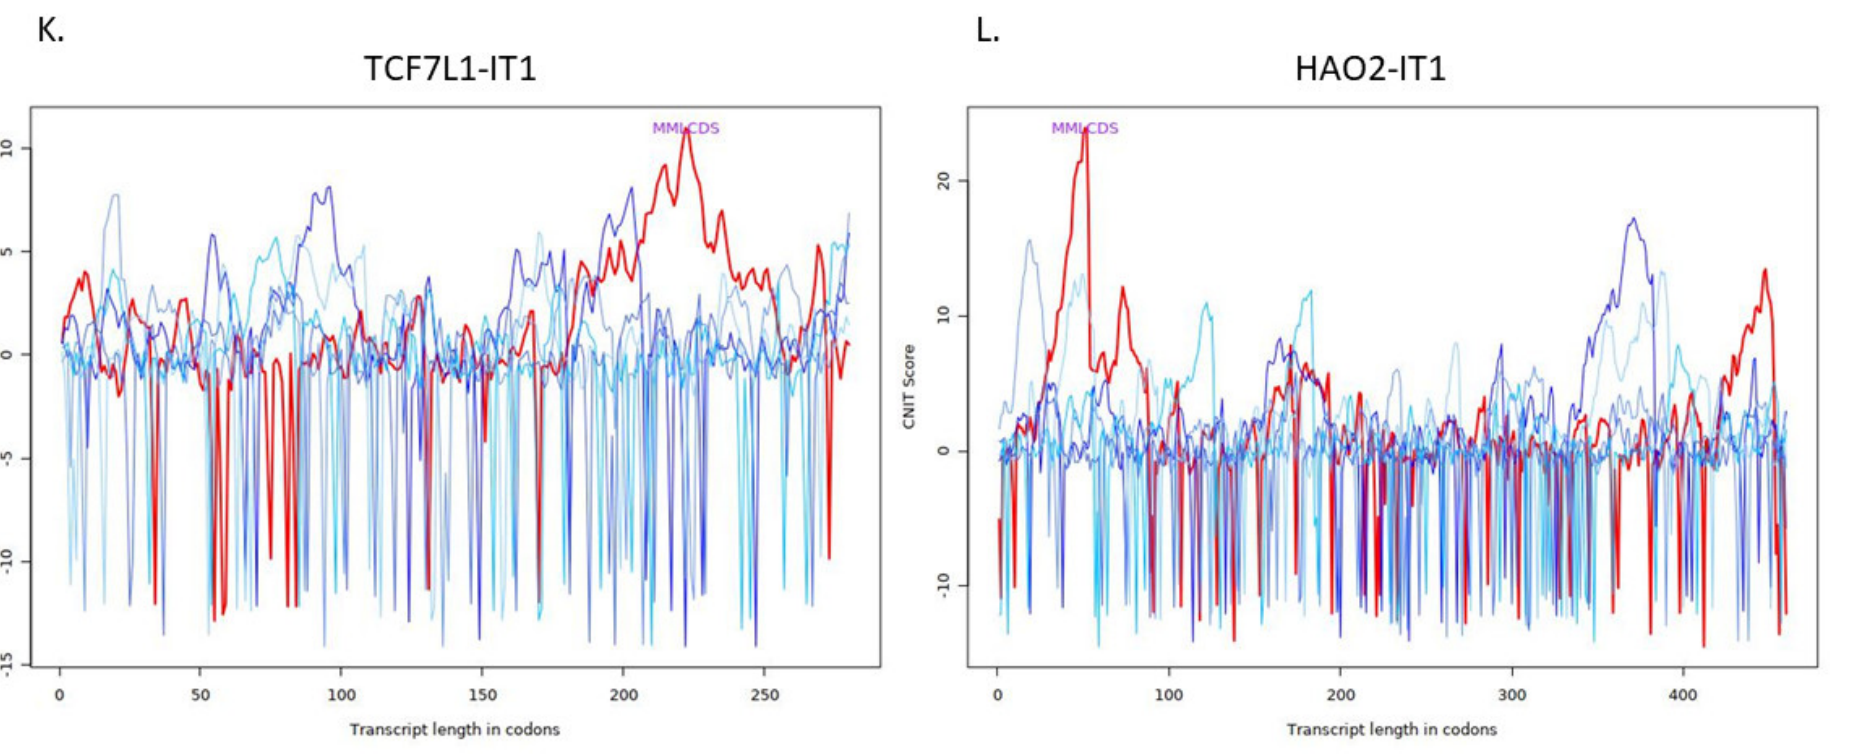
Figure 2. CNIT Score Detail Plots of ( A ) ERI3-IT1, ( B ) NRG1-IT1, ( C ) SND1-IT1, ( D ) FGF14-IT1, ( E ) ANKRD44-IT1, ( F ) AGAP1-IT1, ( G ) DIP2A-IT1, ( H ) LMO7DN-IT1, ( I ) SLIT2-IT1, ( J ) RNF216-IT1, ( K ) TCF7L1-IT1, and ( L ) HAO2-IT1. Red line represents the correct transcriptional reading frame and other five lines (blue or green) represent other five reading frames. Green line highlights the distribution of the coverage (the right y-axis) of the most-like coding domain sequence (MLCDS) region for each transcript across the normalized length. The x axis indicates transcript length in codons, whereas y axis indicates CNIT score. The total length of the identified sequence of transcripts converted to codons length (the identified sequence length/3).